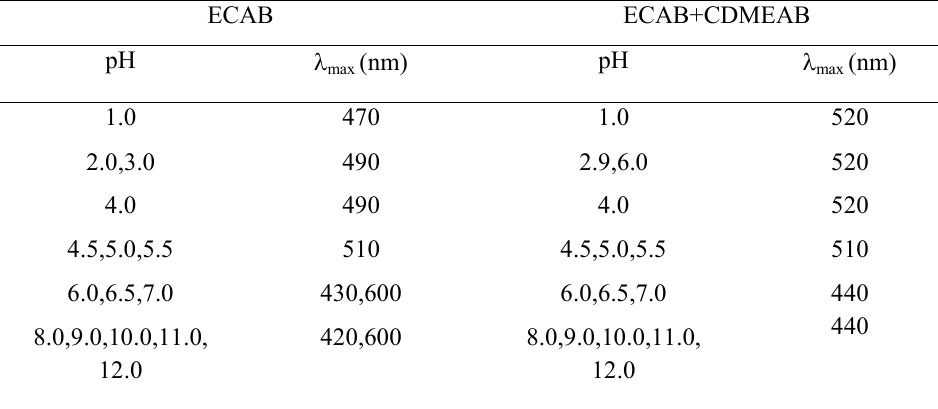
Table 1. Wavelengths of maximum absorbance of ECAB in absence and presence of